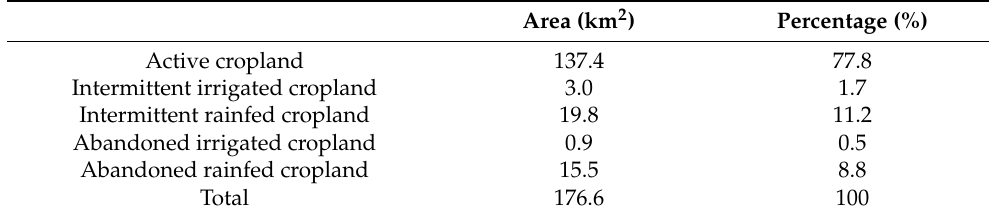
Table 3. The area and percentage of active cropland, intermittent cropland, and abandoned